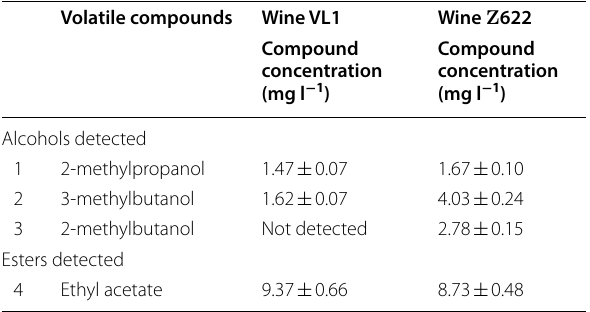
in the wines produced by the commercial (VL1) or the indigenous (Z622) yeast strains, on day 1 Volatile compounds